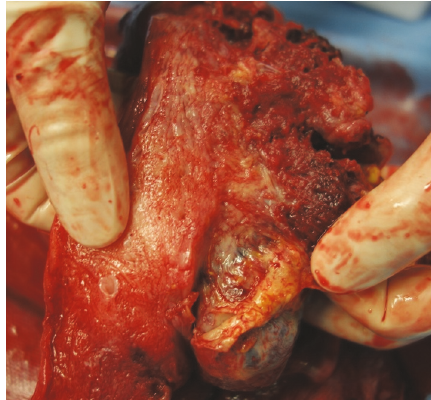
Figure 3: Resected uterus: placenta is present from the fundus to the posterior uterine wall. The placenta adheres diffusely to the myometrium, and partial thinning is visible at the